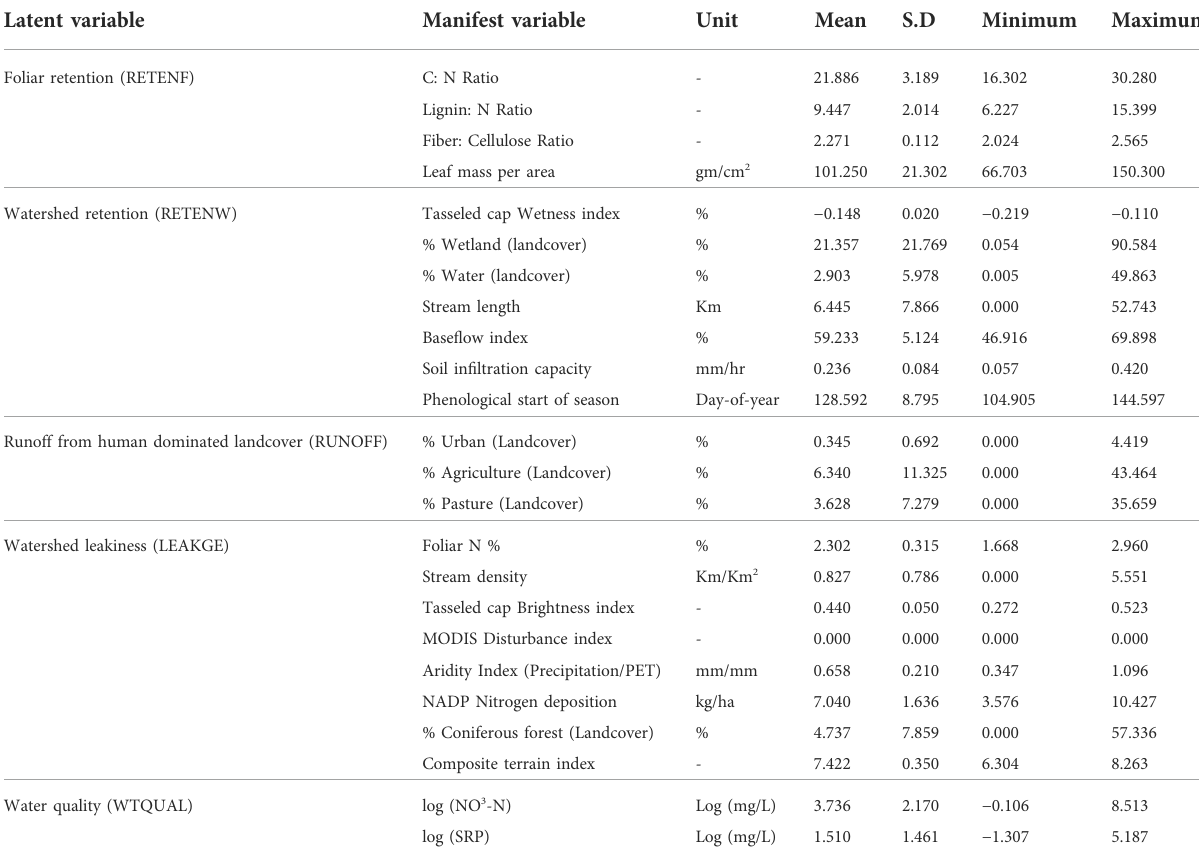
TABLE 2 Basic statistics of the variables used in the study; units, means, standard deviations and ranges are presented. Latent